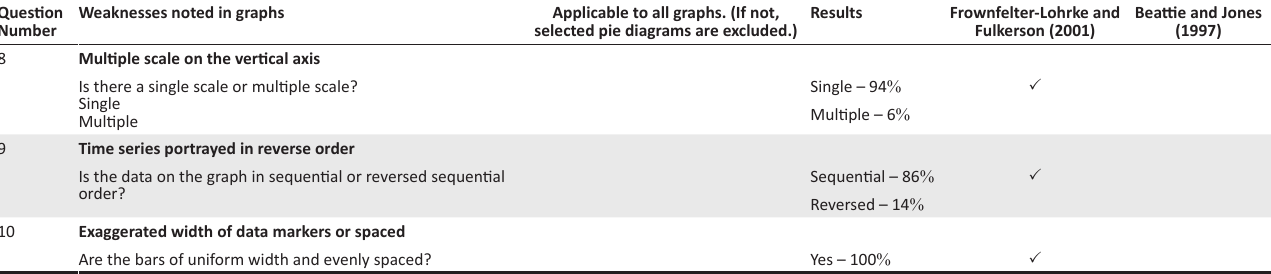
TABLE 1-A1 (Continues...): Checklist used to determine compliance with good graph guidelines. The questions were based on the study completed by Frownfelter-Lohrke and Fulkerson (2001); however additional questions were obtained from the study completed by Beattie and Jones (1997). The source of the question is noted below: Question Weaknesses noted in graphs Applicable to all graphs. (If not, Number